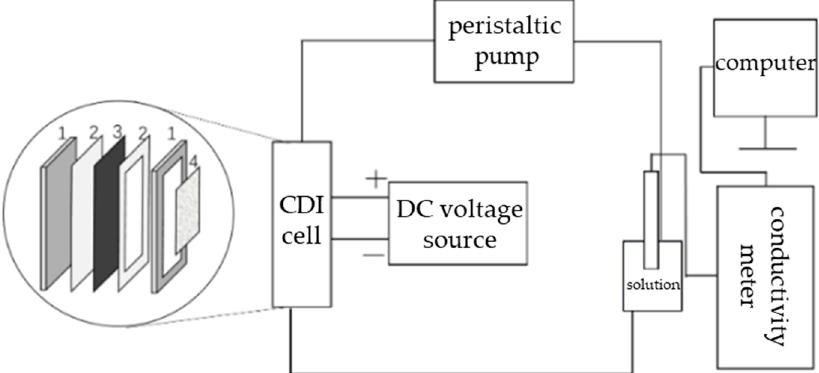
Figure 1. Capacitive deionization (CDI) system diagram and the framework of the CDI cell. Thereinto, 1 is a plexiglass plate as a support plate, 2 is a rubber gasket to prevent the water leakage, 3 is a carbon aerogel (CA) electrode as the working electrode, and 4 is a glass filament separator to prevent short circuiting.